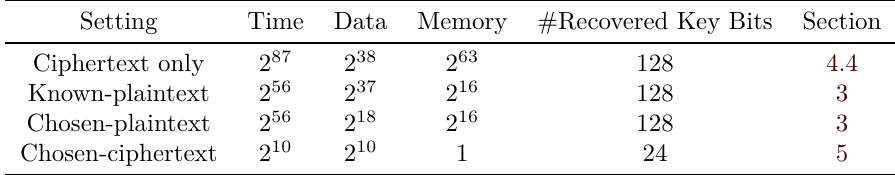
Table 1: Summary of attacks on HALFLOOP-24 presented in this